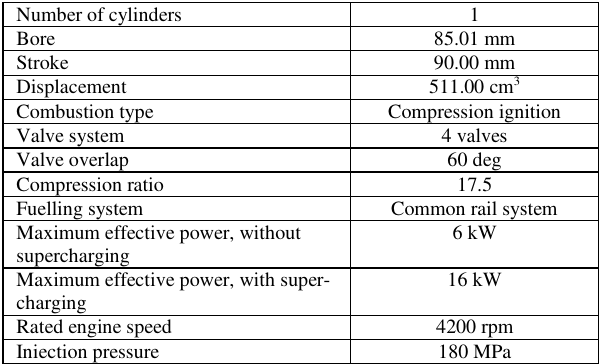
Table 1. Main specifications of the AVL 5402 engine Number of